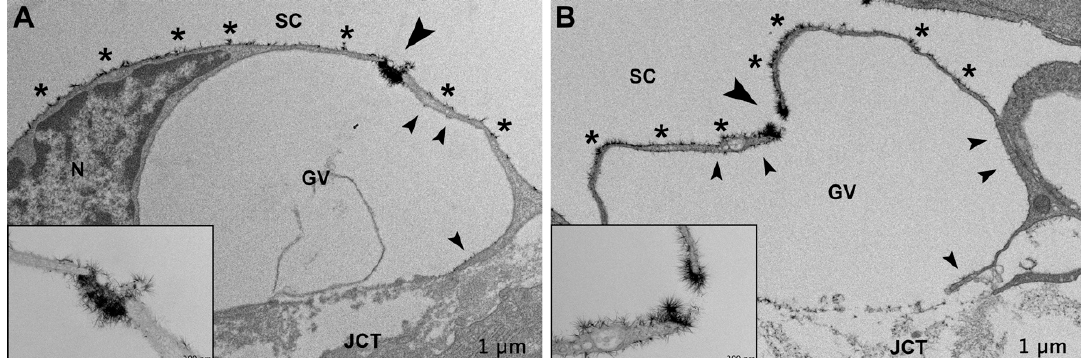
Figure 8. I-pores of giant vacuoles (GVs) filled or unfilled with glycocalyx. ( A ) An example of an I-pore in a GV completely filled with glycocalyx. The large arrowhead indicates the glycocalyx filling an I-pore shown at high magnification in the lower left corner of the panel. The asterisks indicate the glycocalyx on the luminal surface of Schlemm’s canal (SC), and the small arrowheads indicate the glycocalyx on the inner lining of the GV. ( B ) An example of an I-pore of a GV with increased glycocalyx around the edge of the pore, but an unfilled center. The large arrowhead indicates the glycocalyx incompletely filling an I-pore shown at high magnification in the lower left corner of the panel. The asterisks indicate glycocalyx on the luminal surface of SC and the small arrowheads indicate the glycocalyx along the inner lining of the GV. JCT: juxtacanalicular connective tissue; N: inner wall endothelial cell nucleus.